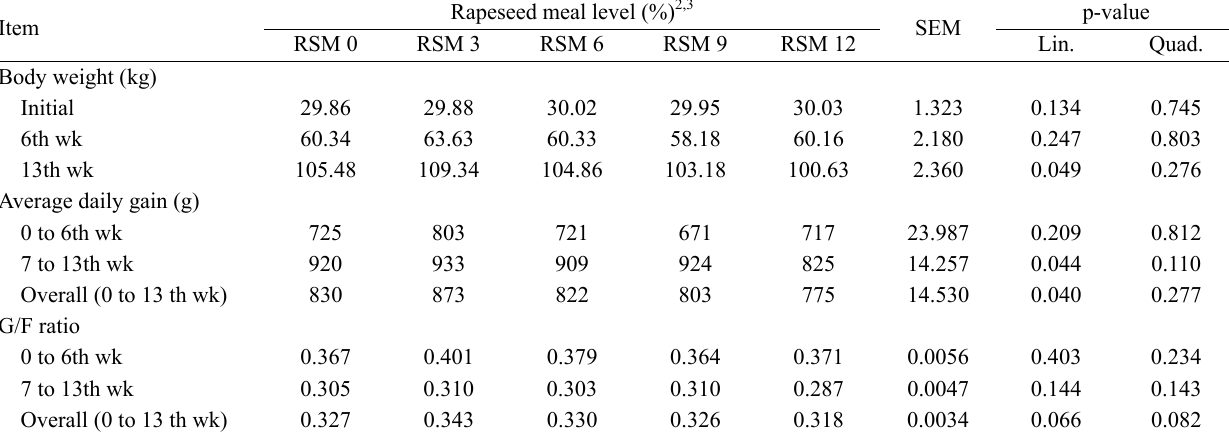
Table 5. Influence of dietary rapeseed meal (RSM) on growth performance of growing and finishing pigs 1